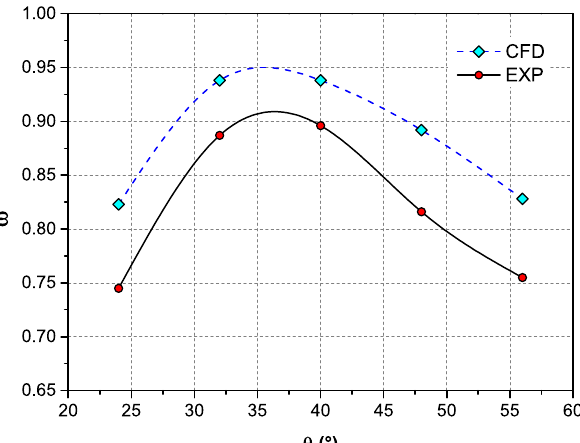
Figure 8. Comparison of the predicted results and experimental data for ω with different θ .